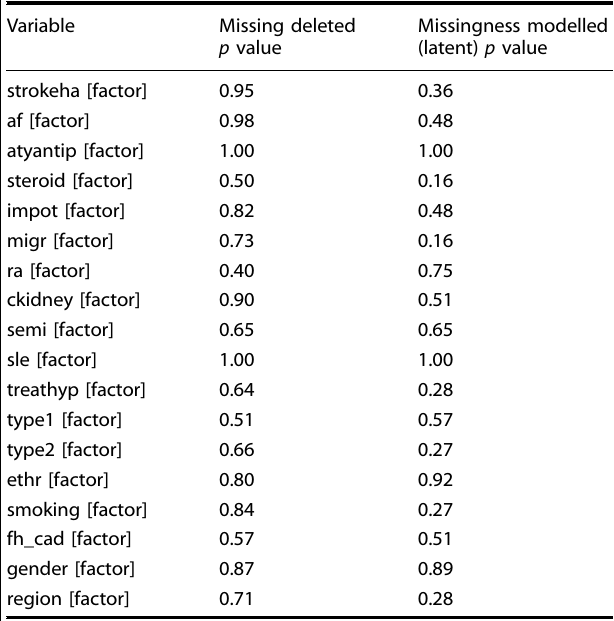
Chi-squared tests comparing distributions between synthetic and ground truth data for categorical variables.